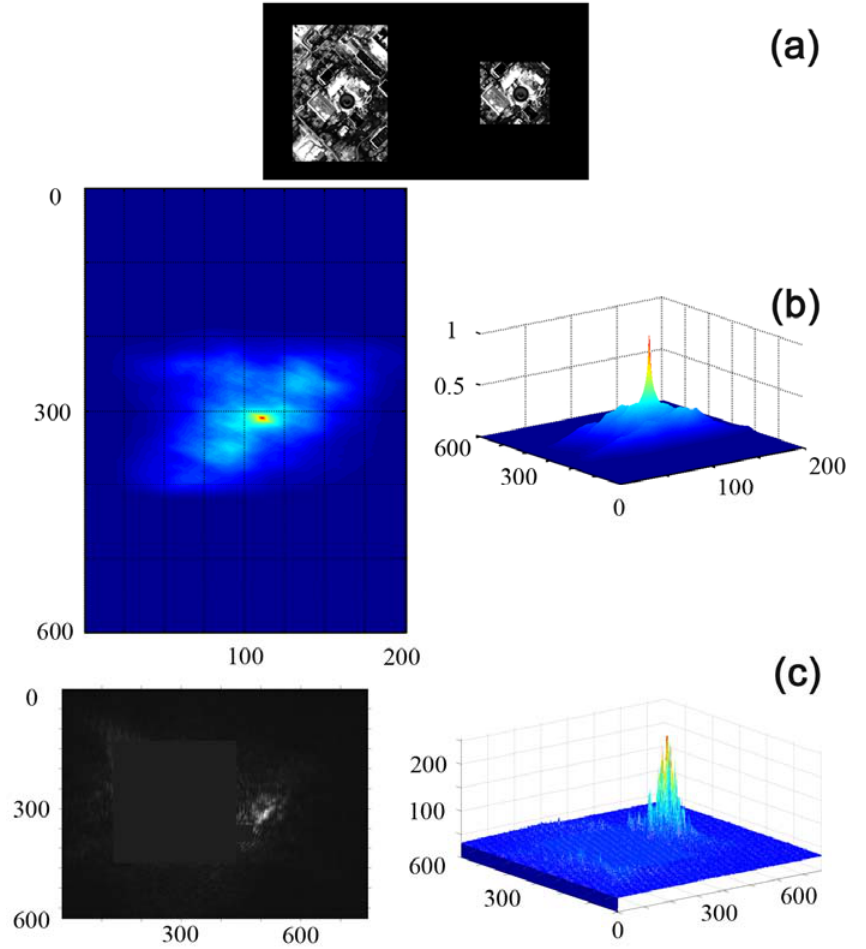
Figure 27. Correlation analysis of a satellite photograph of a commercial development region; the sequence order ( a – c ) and measuring units are as in Figure